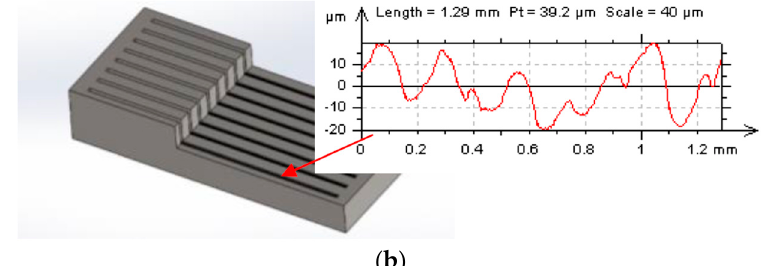
Figure 3. Scheme of measuring: ( a ) slot width on the optical microscope; ( b ) surface roughness. Material removal rate was calculated based on the measured each sample: slot width, length and depth (which define the volume of material removed from the workpiece) divided by machining time: